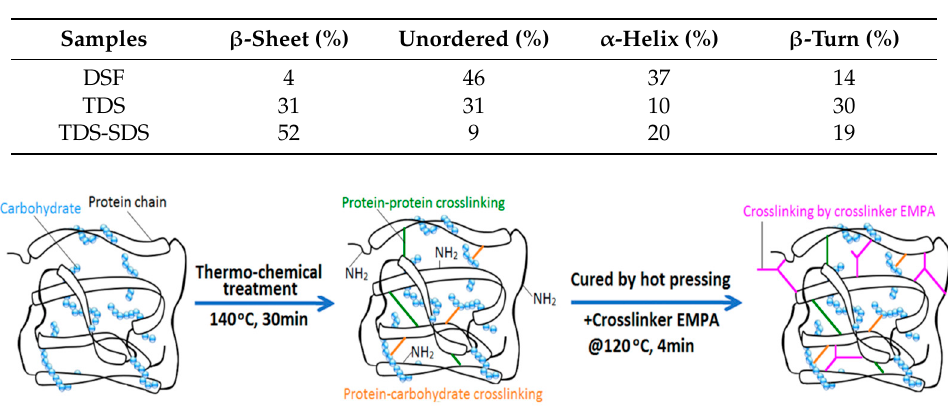
Figure 8. Schematic illustration of the crosslinking modes of TDS-SDS and its cured adhesive.